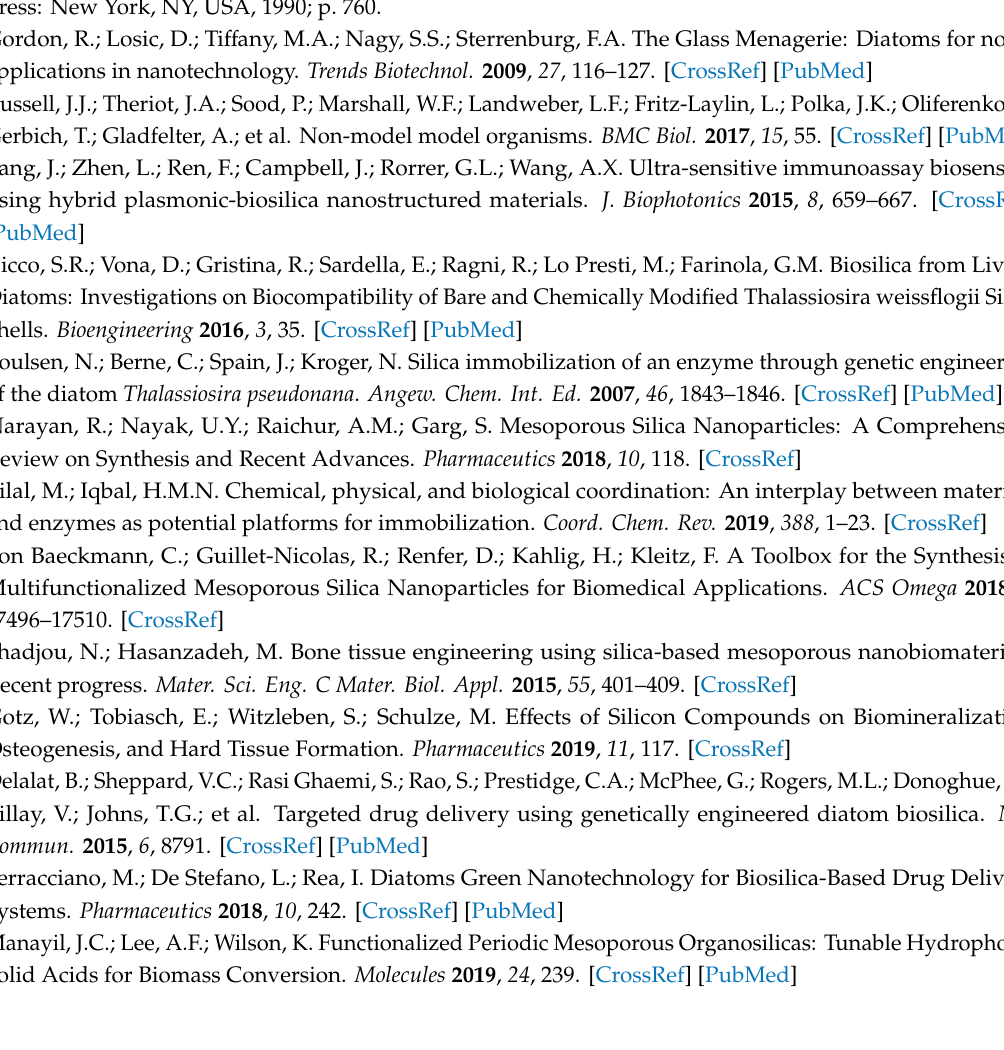
entry clones; Table S3: Gateway entry clones, Table S4: Gateway expression clones, Figure S1: SignalP prediction of ER tra ffi cking sequence, Figure S2: Illustration of two single domain antibodies bound to antigen, Peptide sequences of fusion